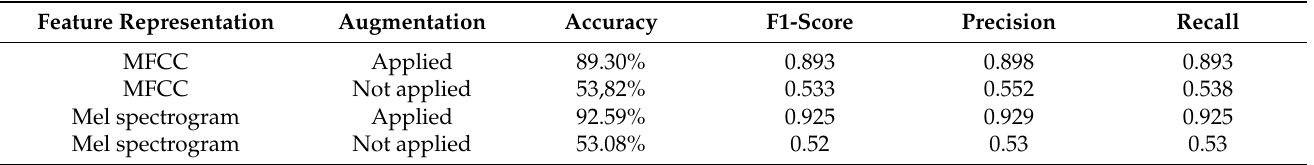
Table 6. Results of CNN-based classification of the FSC22